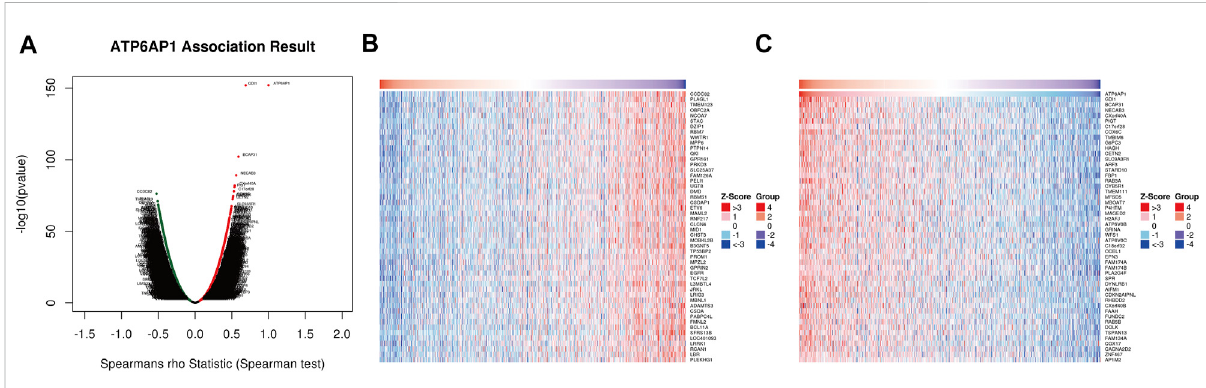
FIGURE 3 Co-expressed genes related to ATP6AP1. (A) Analysis of Spearman correlation found that co-expressed genes were strongly related to ATP6AP1 in breast cancer; red and green dots represent positively and negatively correlated genes, respectively. (B) ATP6AP1 was negatively correlated with the fi rst 50 genes in the heat map. (C) ATP6AP1 was positively linked with the fi rst 50 genes in the heat